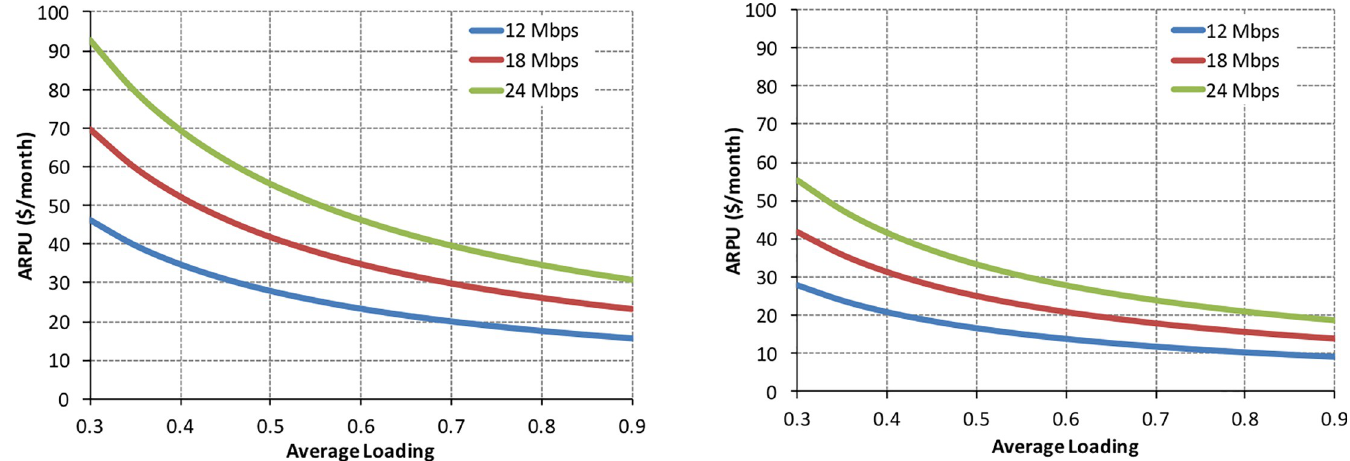
Fig 13. Required ARPU versus average loading for the medium-sized HTS to break-even in 5 years (left panel) and 15 years (right panel).